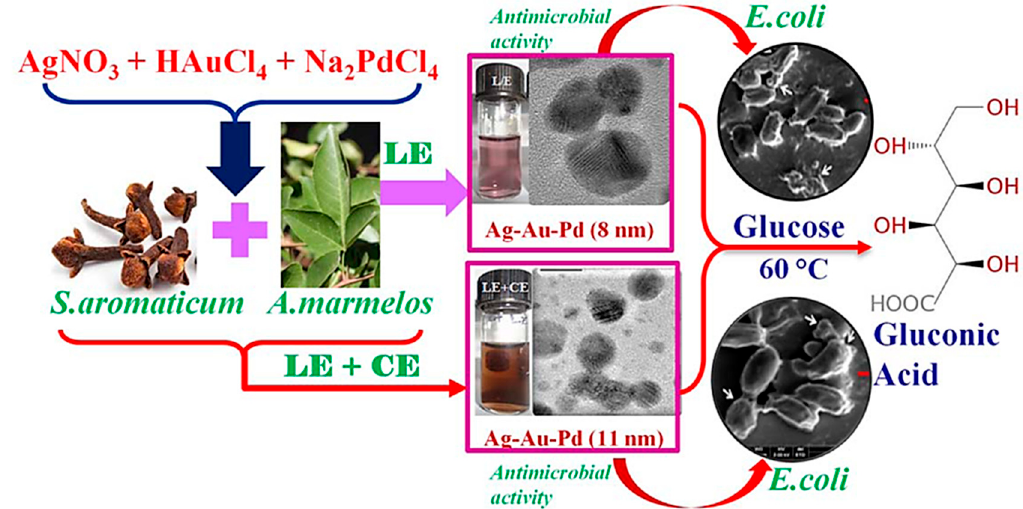
Figure 7. Schematic illustration of the fabrication of trimetallic NPs and their catalytic activities in the glucose oxidation and / or antimicrobial applications. Reproduced from [88], with permission from American Chemical Society, 2015.